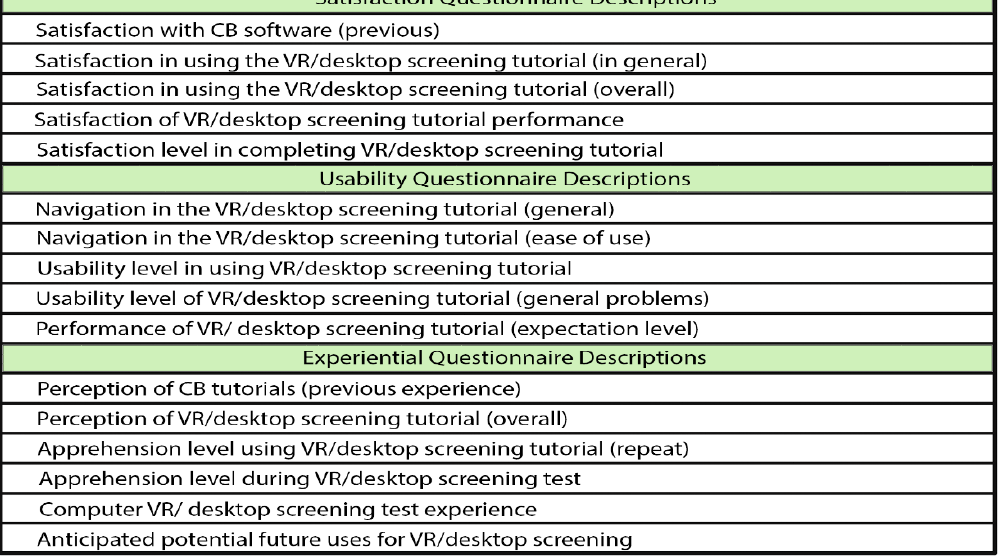
Figure 8 . Revised Purdue spatial visualization test.